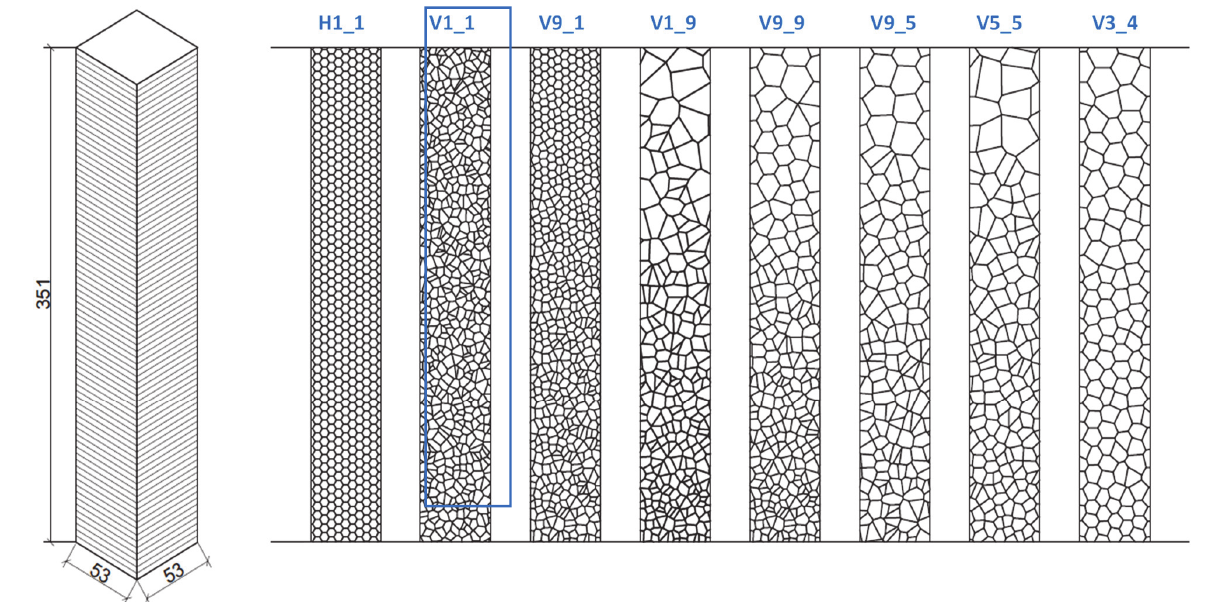
Figure 23: Voronoi patterns: constant/variable irregularity and